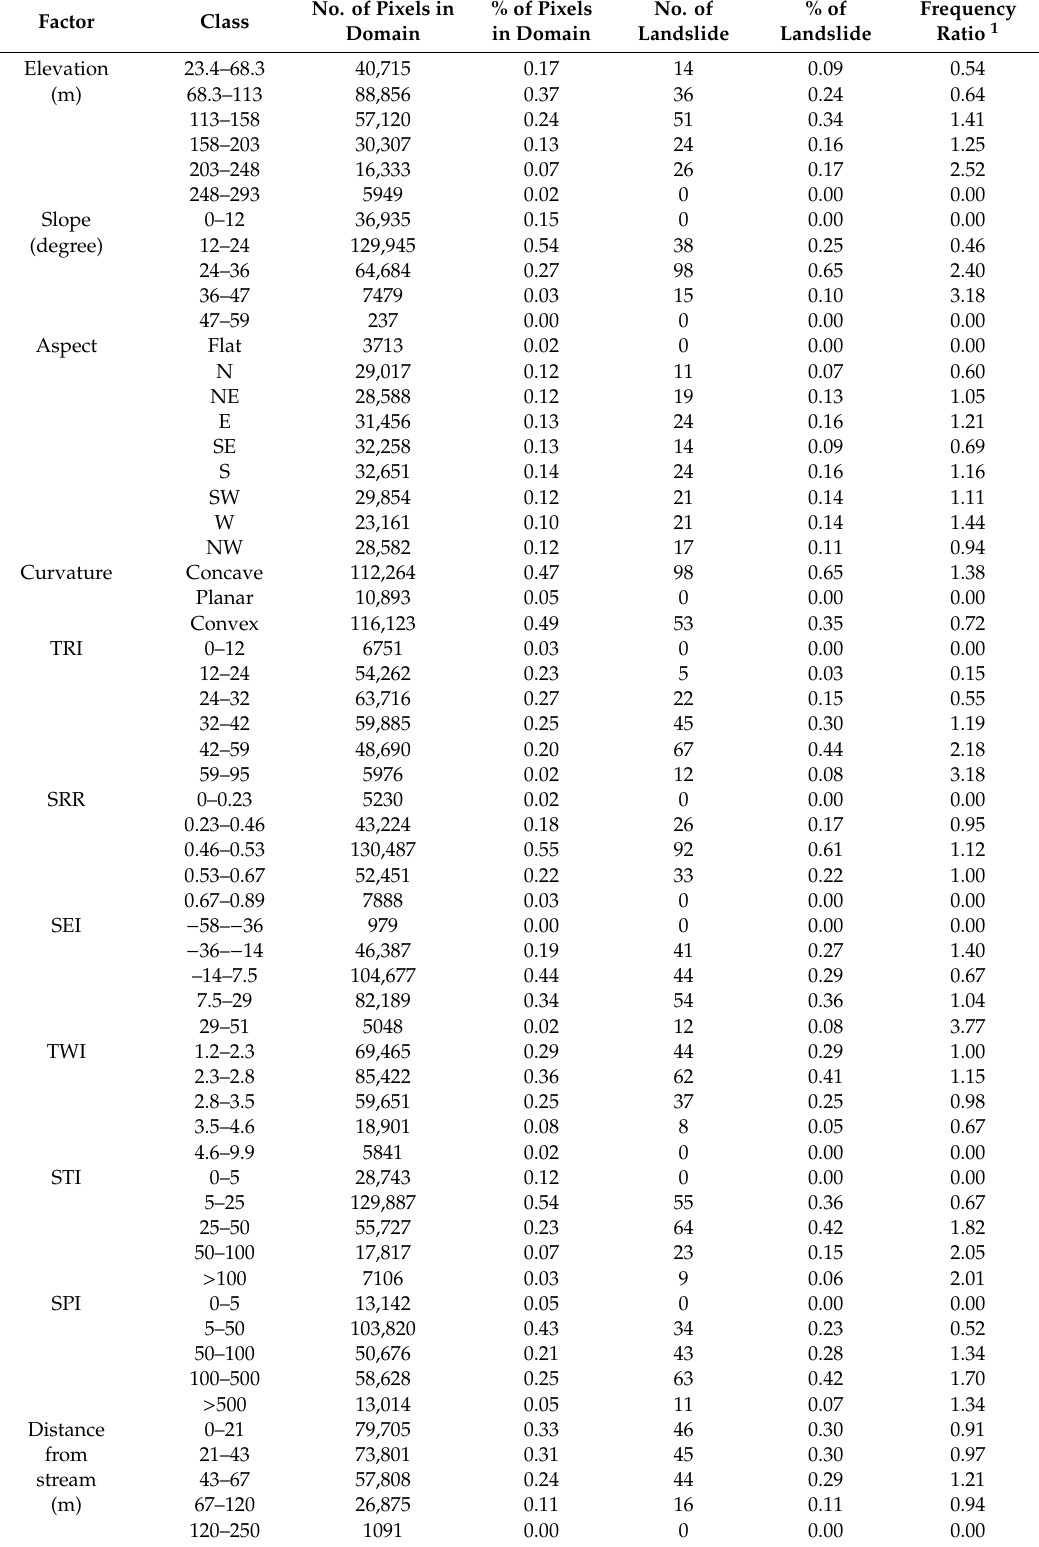
Table A1. Frequency ratio between landslides and predisposing